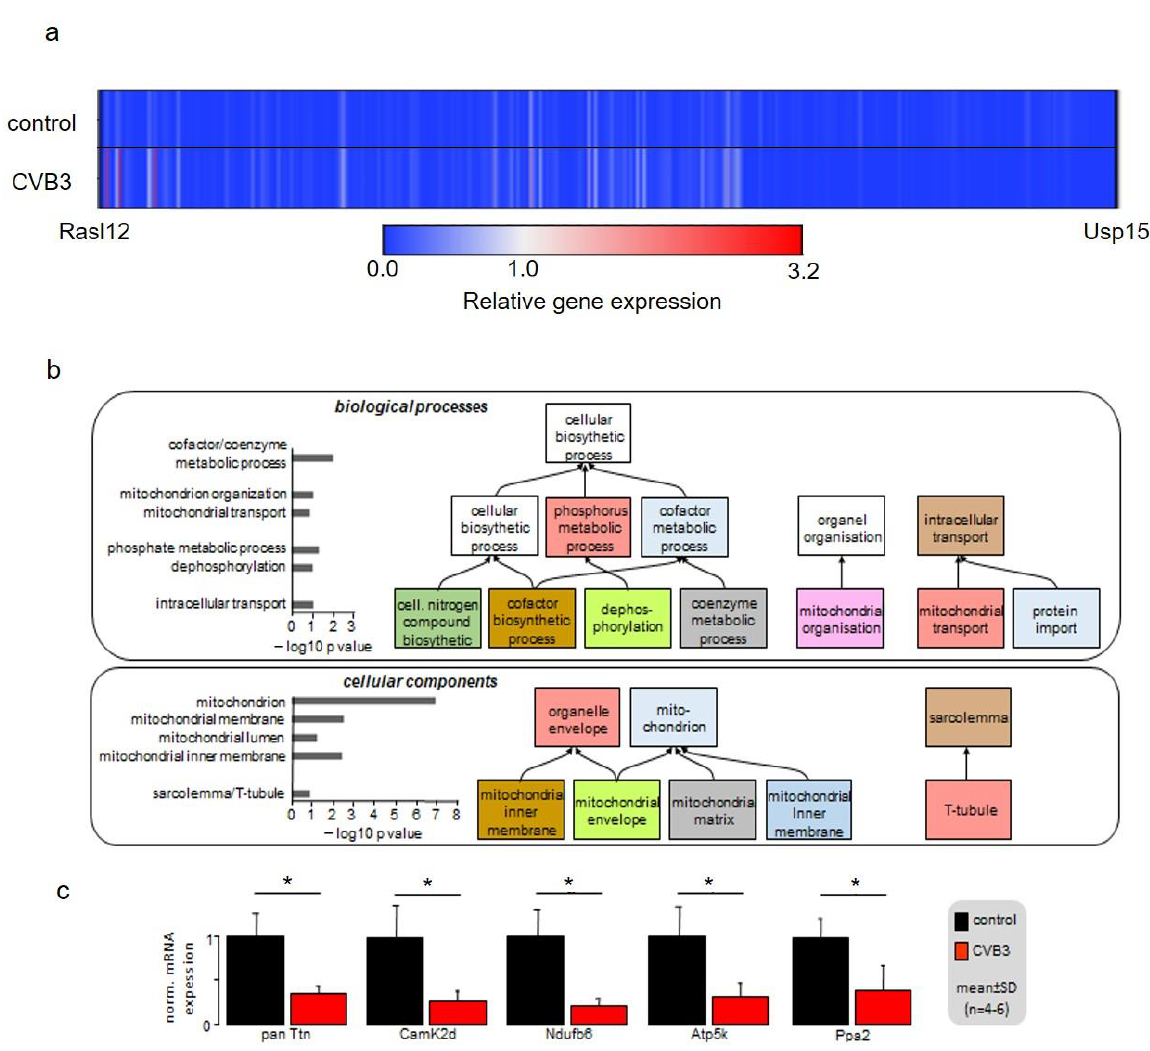
Figure 6. ( a ) Gene expression pattern of control and CVB3-expressing mice illustrated as a heatmap. Gene expression levels were averaged and normalized to the expression of cardiac ACTC1, which were not altered under CVB3 expression. ( b ) Gene array analysis and qPCR validation of regulated key genes in age-matched wt and CVB3-transgen mice. GO analyses of biological processes and cellu- lar components are shown. ( c ) RT-PCR verified downregulation of five key genes (* indicates p <